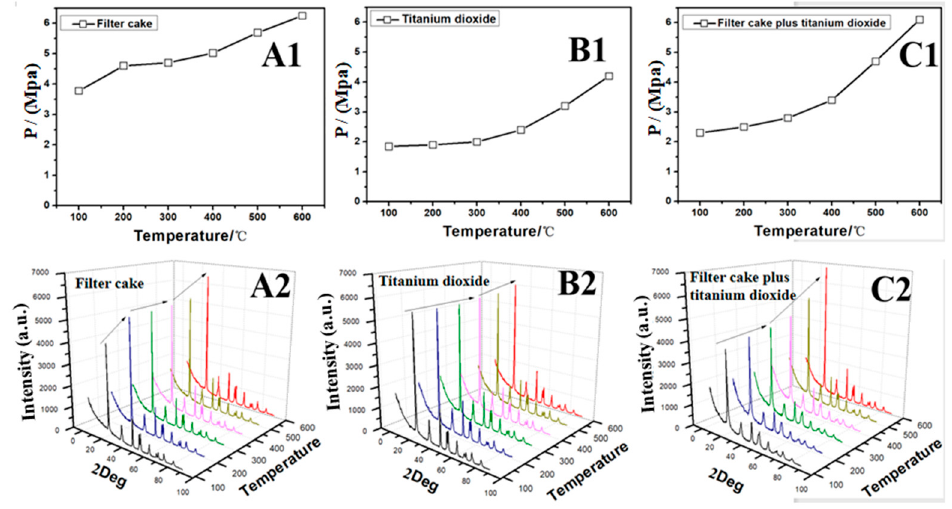
Figure 6. The axial direction strength ( A1 – C1 ) and corresponding XRD patterns ( A2 – C2 ) for honeycomb catalysts produced by different titanium sources treated at different temperature.